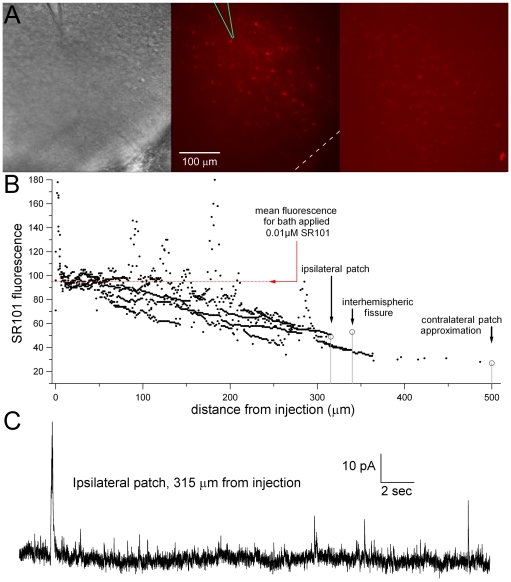
Microinjection solution (200 µM bicuculline+10 µM SR101) concentration decreases with distance and does not directly affect contralateral cortex.(A) Representative IR-DIC (left) and SR101 fluorescence (middle) images of a single microinjection from the injection pipette (bic. electrode). The bic. electrode (green) and the interhemispheric fissure (white dashed line) are highlighted in the SR101 image (middle panel). Note the disappearance of visible SR101 fluorescence in the vicinity of the interhemispheric fissure. A slice that was bathed in 0.01 µM SR101 for 30 minutes, followed by a 15 minute wash, is displayed as a reference (right panel). (B) SR101 fluorescence is reduced over 1000-fold from the 10 µM SR101 in the bic. electrode solution. Each black dot represents the grayscale brightness of one measured sample pixel at various distances from the tip of the injection (n = 1137). Dashed red line indicates the mean grayscale brightness from the 0.01 µM SR101 application displayed in A (mean pixel brightness = 94.5, standard deviation = 6.9), suggesting that the bic. injection falls to a 1000-fold dilution at approximately 300 µm distance from the tip of the bic. electrode. The “ipsilateral patch” represents an ipsilateral layer 2/3 neuron from which IPSCs were recorded during the injection. (C) Whole-cell patch clamp recordings ipsilateral to a bic. microinjection reveal spontaneous IPSCs. This neuron, located 315 µm away from the tip of the injection pipette, was voltage clamped at +10 mV using cesium gluconate to isolate GABA-A IPSCs. The presence of these IPSCs indicates that the concentration of bicuculline from the injection pipette at this distance did not sufficiently promote GABA-A antagonism.